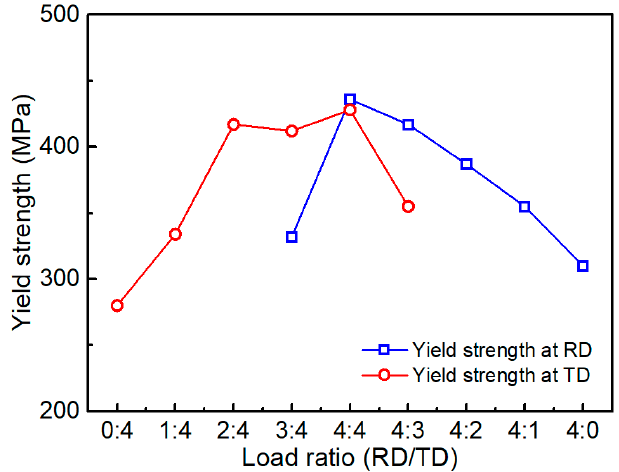
Figure 8. Variation of yield strength at different load ratios.